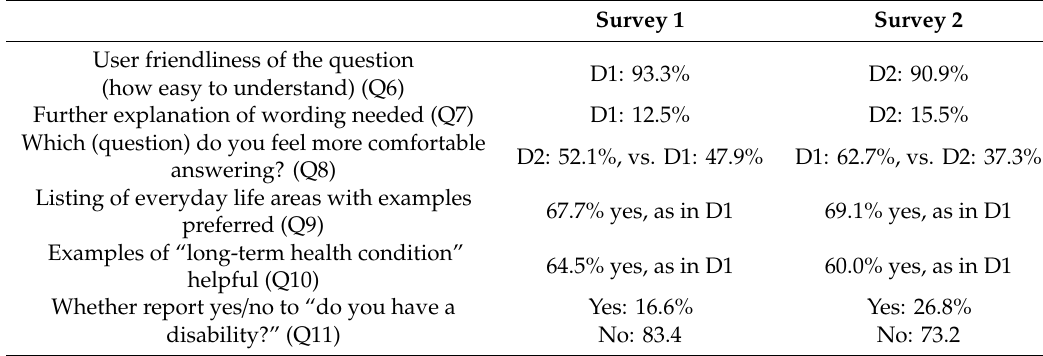
Table 6. Results for questions D1 and D2 (Surveys 1 and 2). Survey 1 Survey